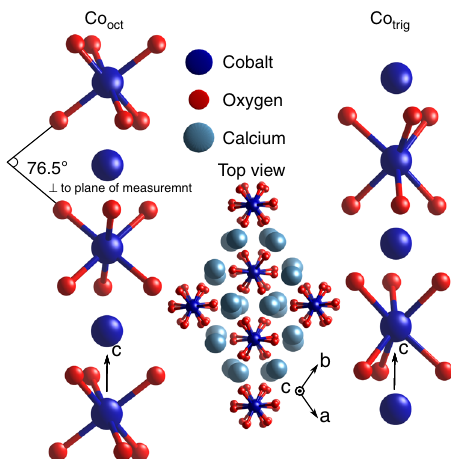
Fig. 1 The crystal structure of Ca 3 Co 2 O 6 consists of chains of Co atoms along the c -axis, where each cobalt site alternates between trigonal and octahedral coordination with the surrounding oxygen ligands. Additionally, both trigonal and octahedral sites alternate, with each having a 45° rotation about the c -axis relative to their nearest neighbor (along the c -axis) of the same coordination. In the ab -plane (top view), the chains form a triangular- type lattice.